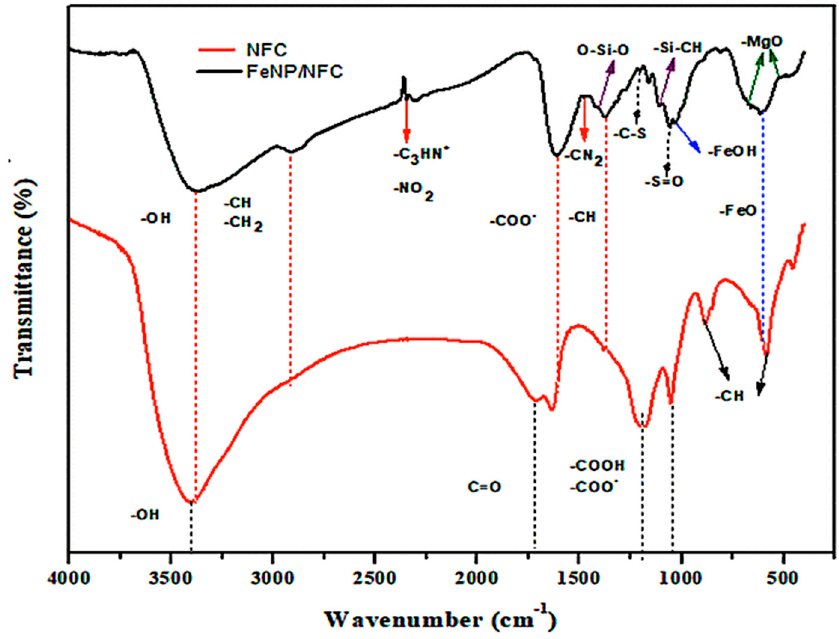
Figure 4. Fourier Transform Infrared Spectroscopy (FTIR) spectra of NFC and FeNP/NFC samples.